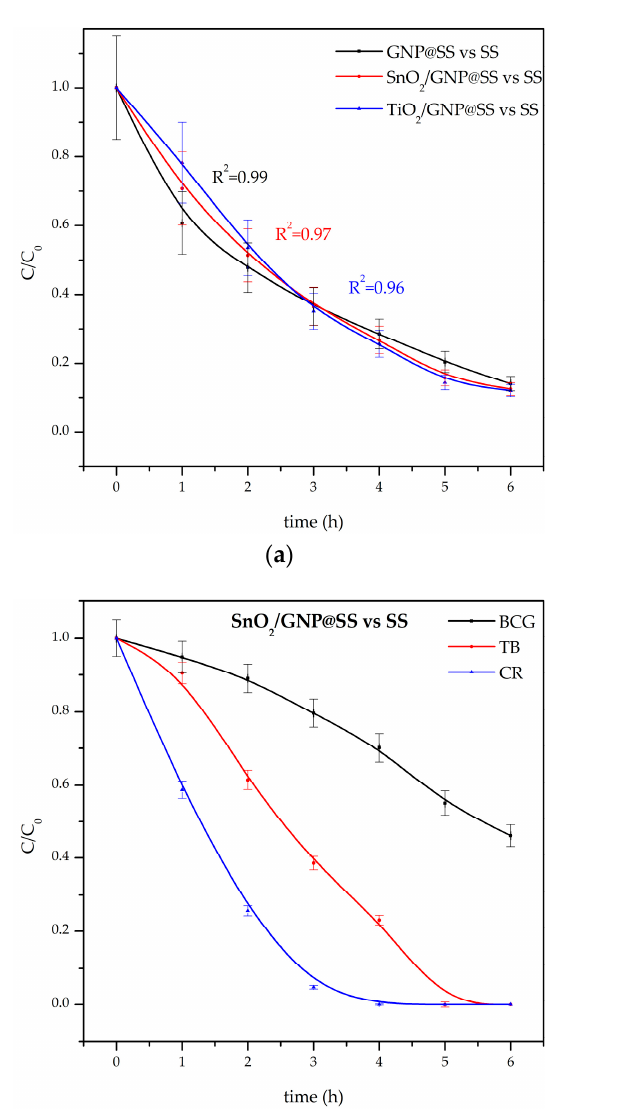
Table 2. Pseudo-first-order rate constants of degradation of cresol red and total dyes mixture. Electrode k cresol red , 1/min